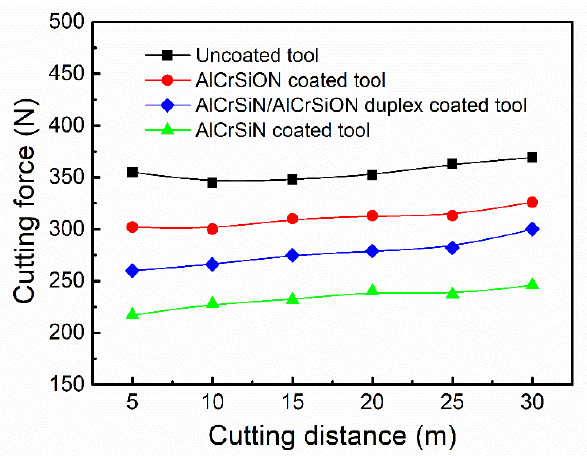
Figure 13. Variation of cutting force at the cutting distance from 5 to 30 m for the uncoated tool, AlCrSiN coated tool, AlCrSiON coated tool, and AlCrSiN/AlCrSiON duplex coated tool.